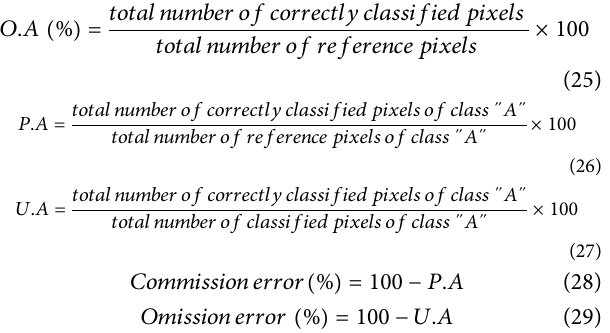
Frontiers in Earth Science |